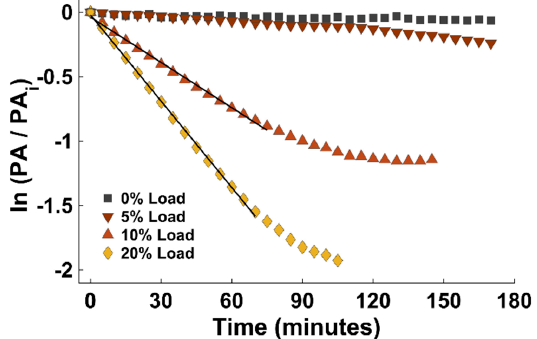
Figure 5. Adsorption curves for MB to TiO 2 /PDMS beads. Visible absorbance spectra are collected in the absence of radiation capable of photolysis or photocatalytic activation to isolate the extent to which